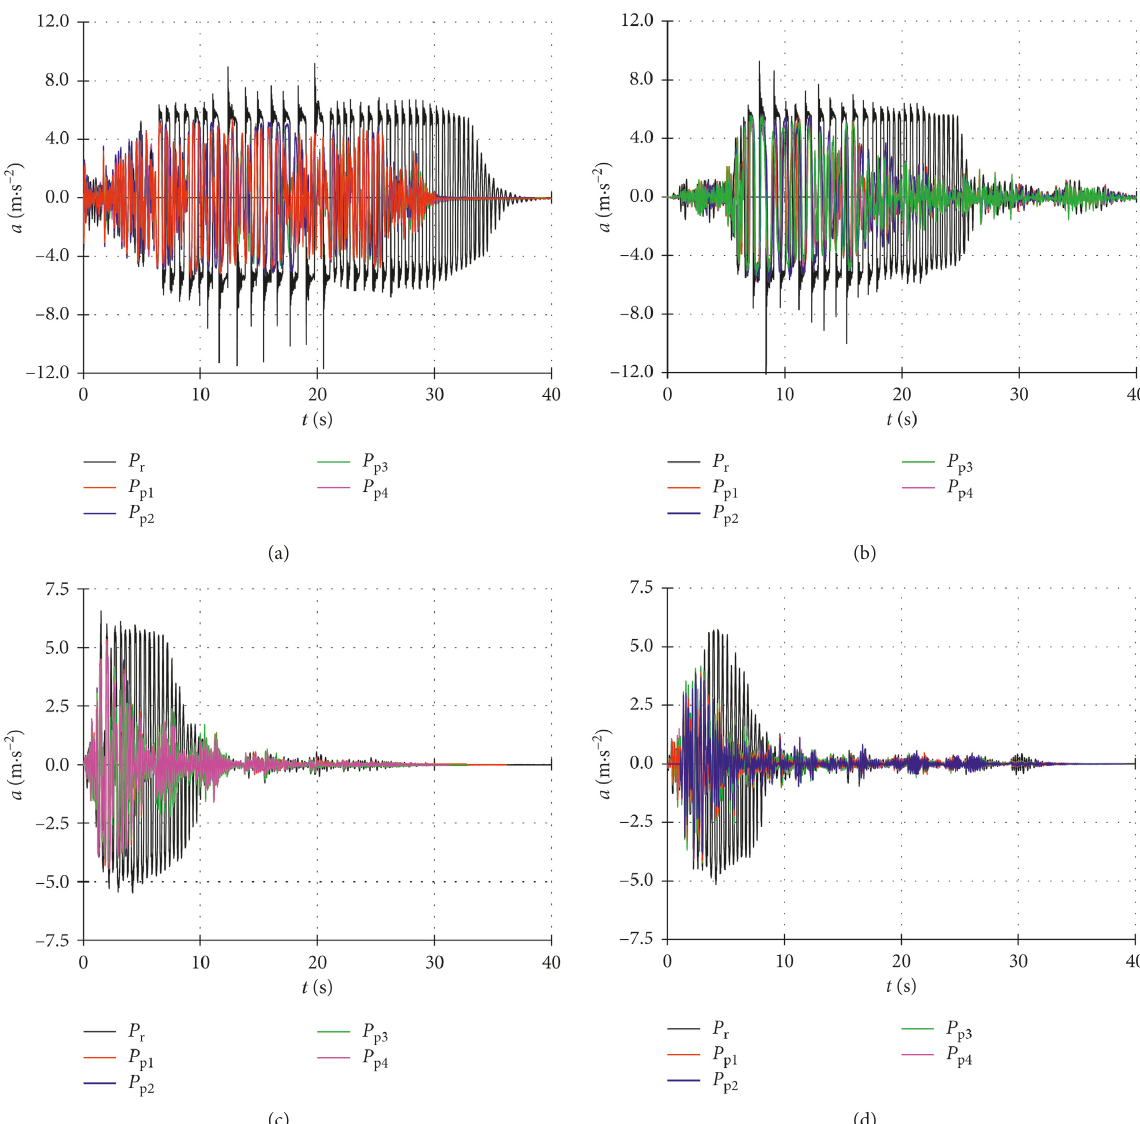
Figure 10: Horizontal acceleration of the mass center at the column top (a) for MSB. (a) Artificial accelerogram (AA). (b) Accelerogram Petrovac (AP). (c) Accelerogram Ston (AS). (d) Accelerogram B. Luka